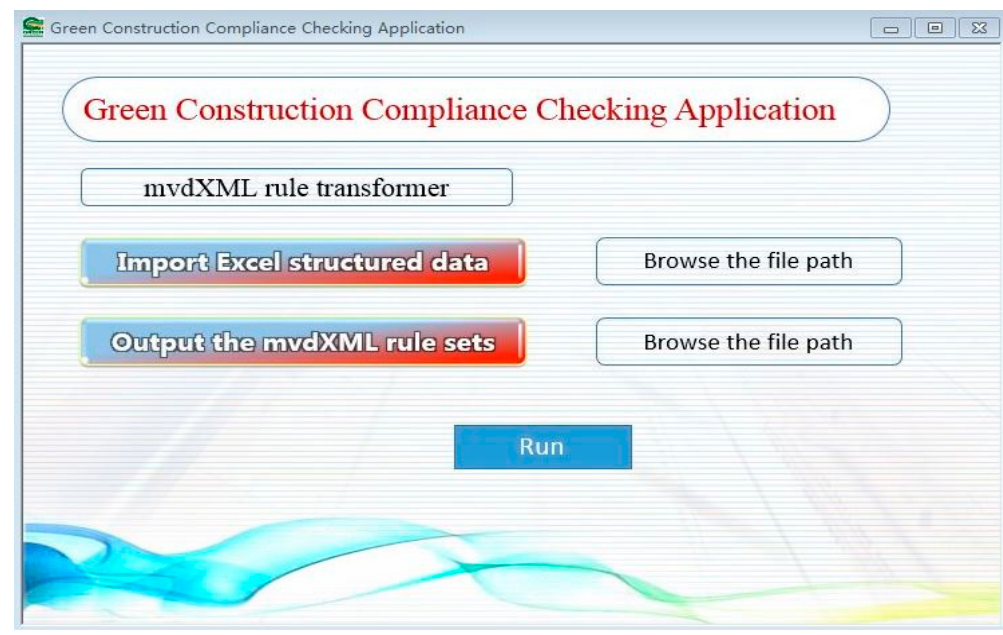
Figure 4. MvdXML rule transformer.